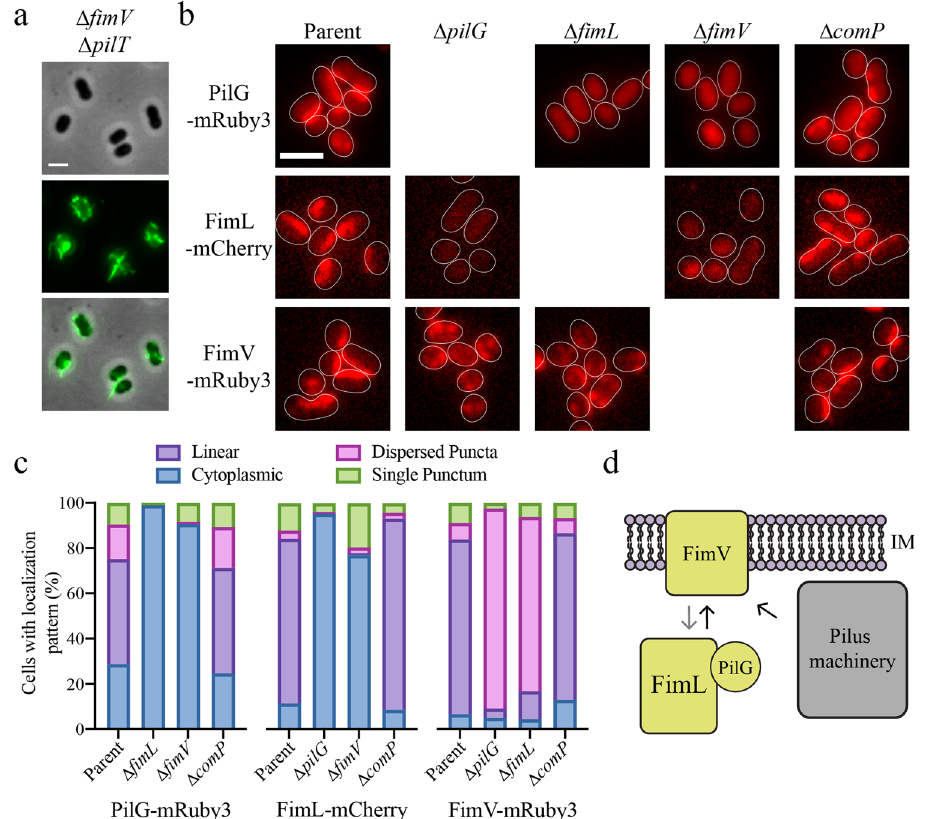
Fig. 3 | The Pil-Chp pathway controls T4P localizationthrough the positioning ofa divergent FimV homologue.a Representative image of a Δ fi mV Δ pilT mutant displaying dispersed T4P labeled with AF488-maleimide dye and with background fl uorescence subtracted. b Representative images of indicated protein fusion strains with background fl uorescence subtracted. White outlines are cell body outlines from phase contrast images. c Quanti fi cation of fl uorescence phenotypes depictedin b .Dataarecompiledfromtwoindependentbiologicalreplicates,anda minimum of 100 total cells were assessed for each strain. d Schematic of the